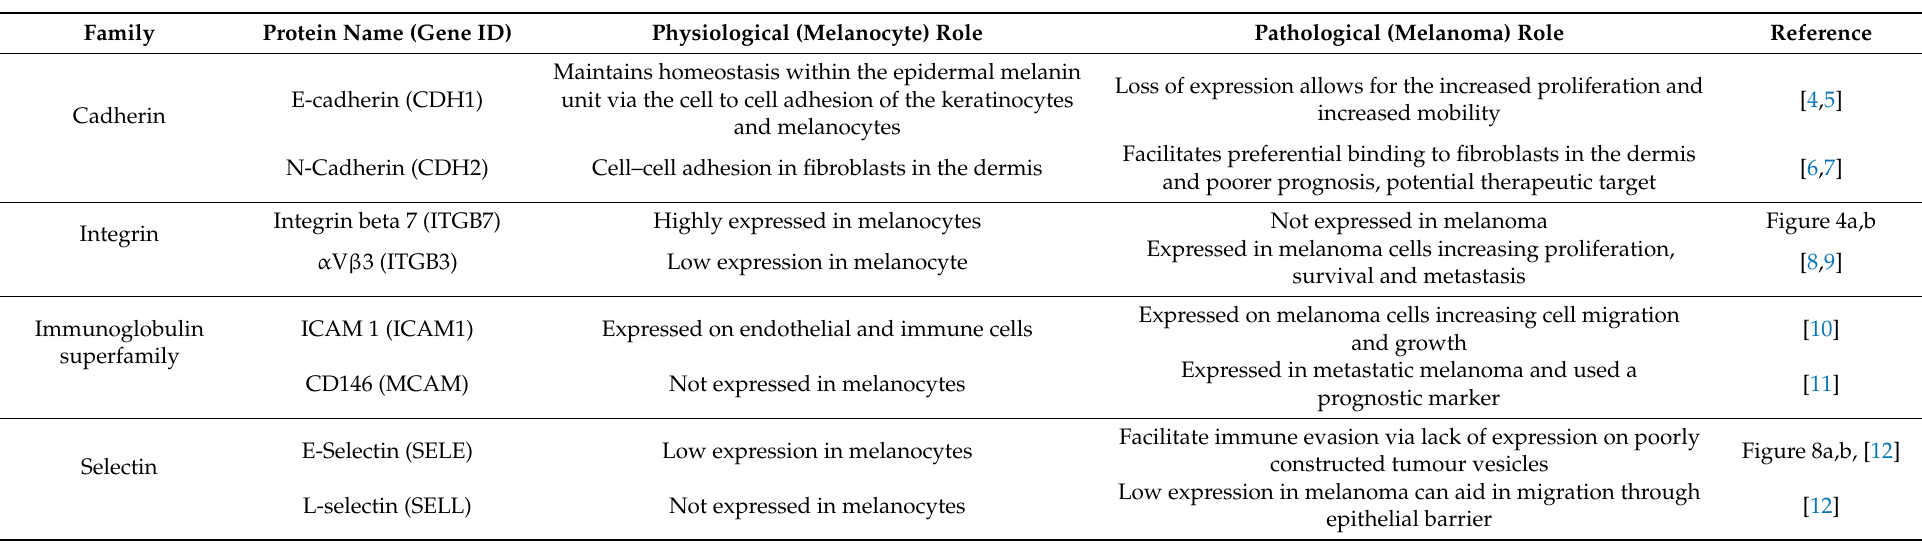
Table 1. Examples of members of the four CAM families and their physiological and pathological